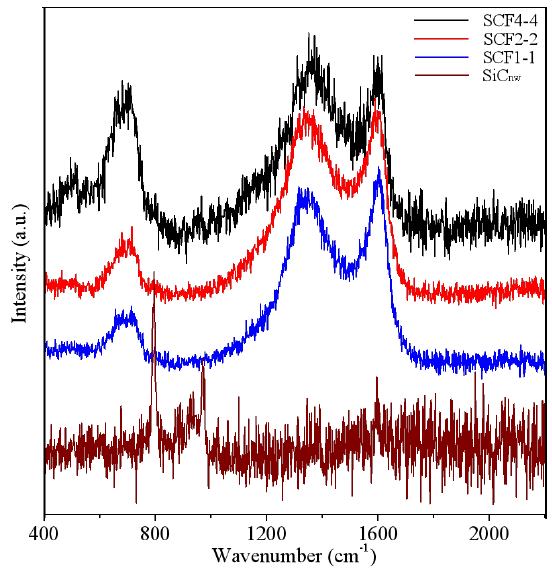
Figure 2. Raman spectra for all samples investigated.